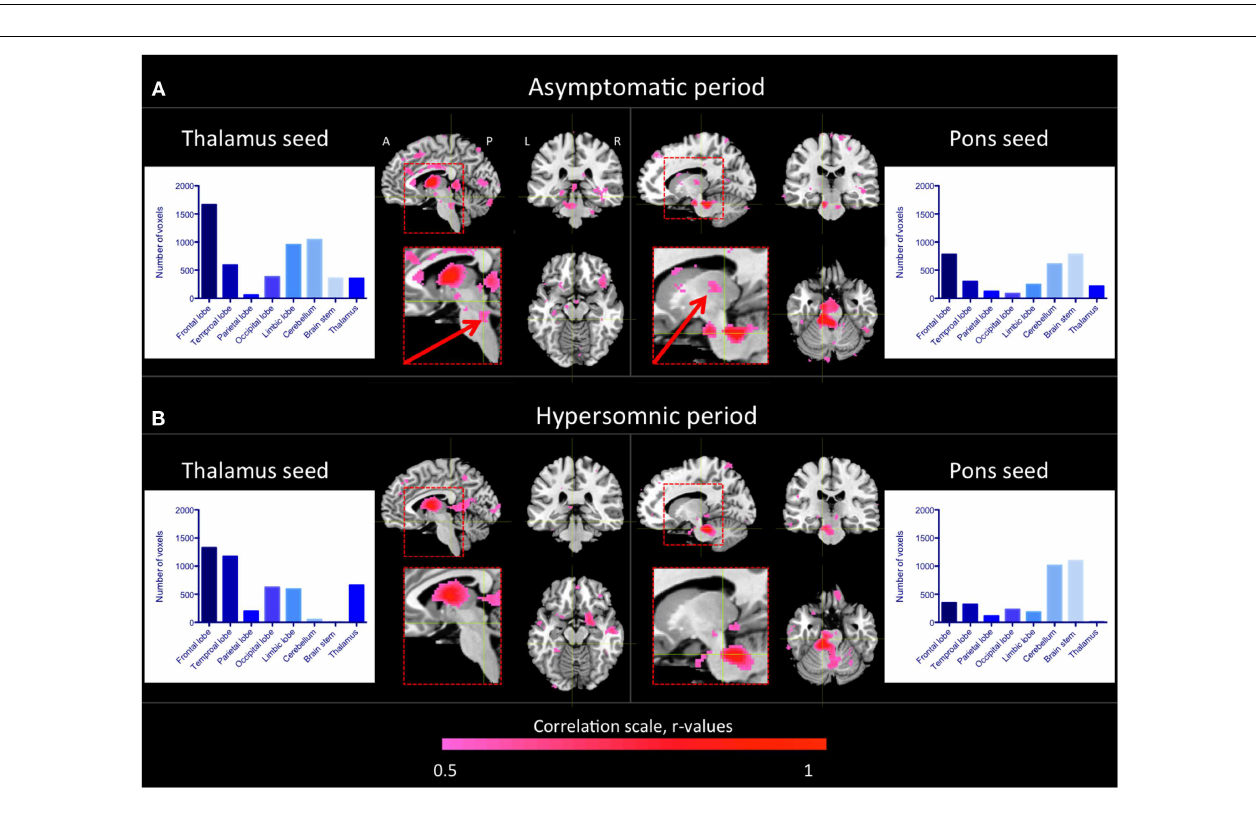
FIGURE 1 |Thalamic and pontine functional connectivity in healthy controls .The images show regions that had significant inter-subject functional connectivity to the thalamus (A) and pons (B) , respectively.The color scale represents t -statistic values in the range of 4–15. A t -value of 4.22